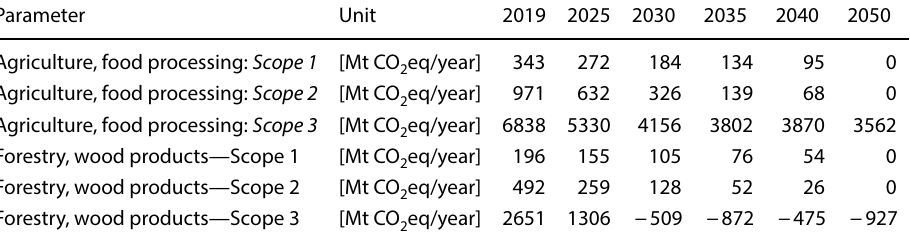
Table 17 Results: Scope 1 , 2 , and 3 emissions of the analysed sectors under the 1.5 °C energy